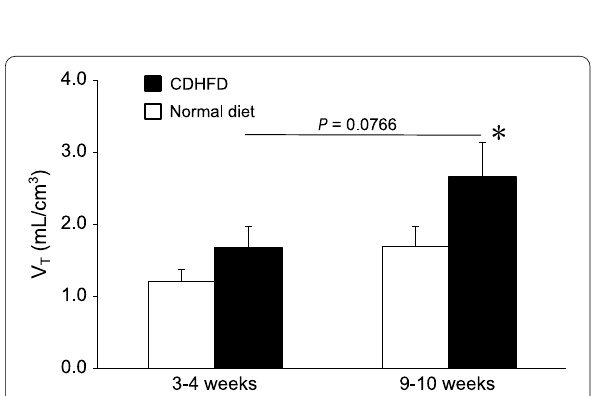
Fig. 6 Hepatic V T analysed by 2T3C model analysis. Values are expressed as means SDs ( n 5). * P < 0.05 compared with the ± = 3–4-week normal diet-fed group. CDHFD